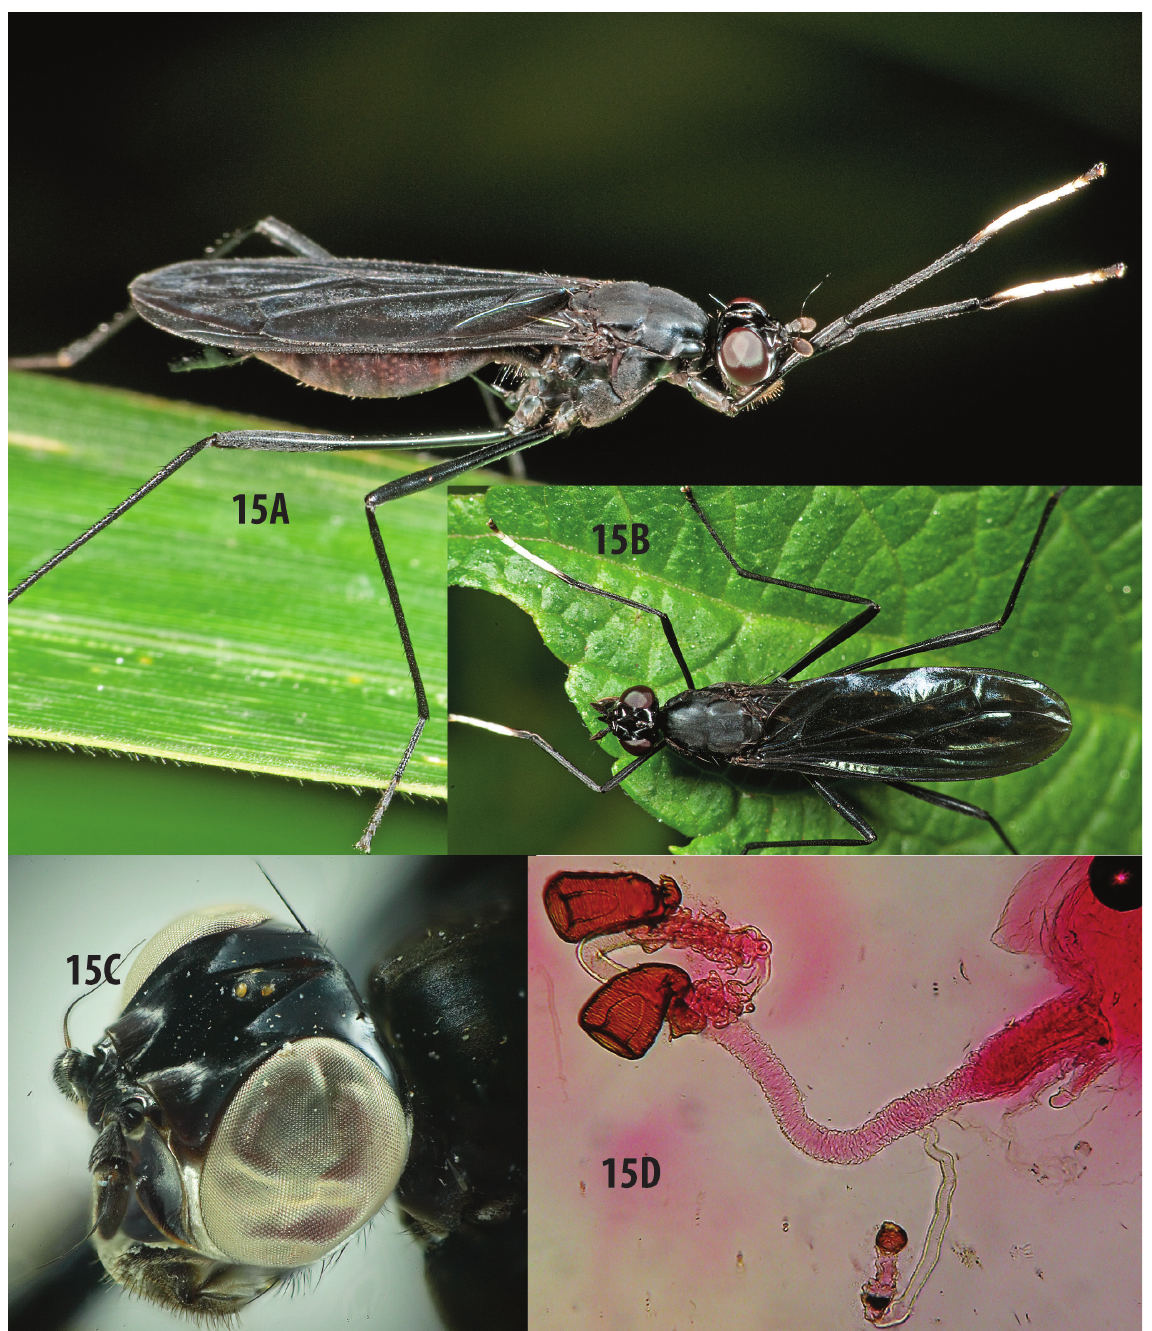
Fig. 15. Mesoconius pasachoa sp. nov . A–B . Holotype prior to capture, ♀, QCAZ. C . Head. D . Spermathecae and associated